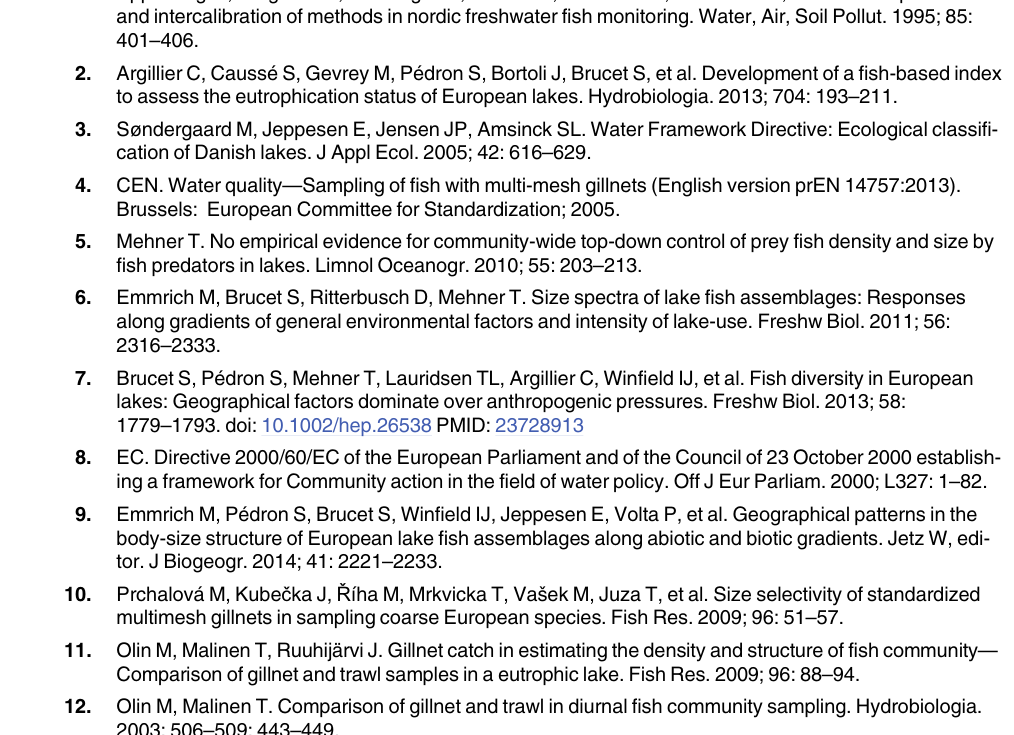
S2 Table. Multimesh gillnet catch and effort summary. Summary of the sampling in 2009 – 2013 in the different water bodies analysed in this study (CZ — Czech Republic, SP — Spain). For each water body, the year of sampling (Year), total gillnet effort (Nets), effort with ESG and LMG nets (ESG nets and LMG nets, respectively), the total number of fish (ESG and LMG fish) and biomass of fish recorded (ESG and LMG biomass in kg) are